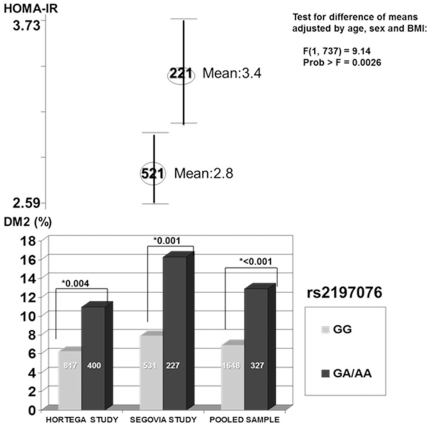
Prevalence of type 2 diabetes and HOMA-IR values according to genotypes of the rs2197076.[Bottom: Prevalence of DM2 for genotypes of the rs2197076 under dominant model. Inside the bars are shown the number of individuals for each genotype; Top: Mean of HOMA-IR for genotypes of the rs2197076 in Segovia population under dominant model. Inside the circles are the number of individuals for each genotype. *Chi-square test for the comparison of type 2 diabetes prevalence between genotypes].